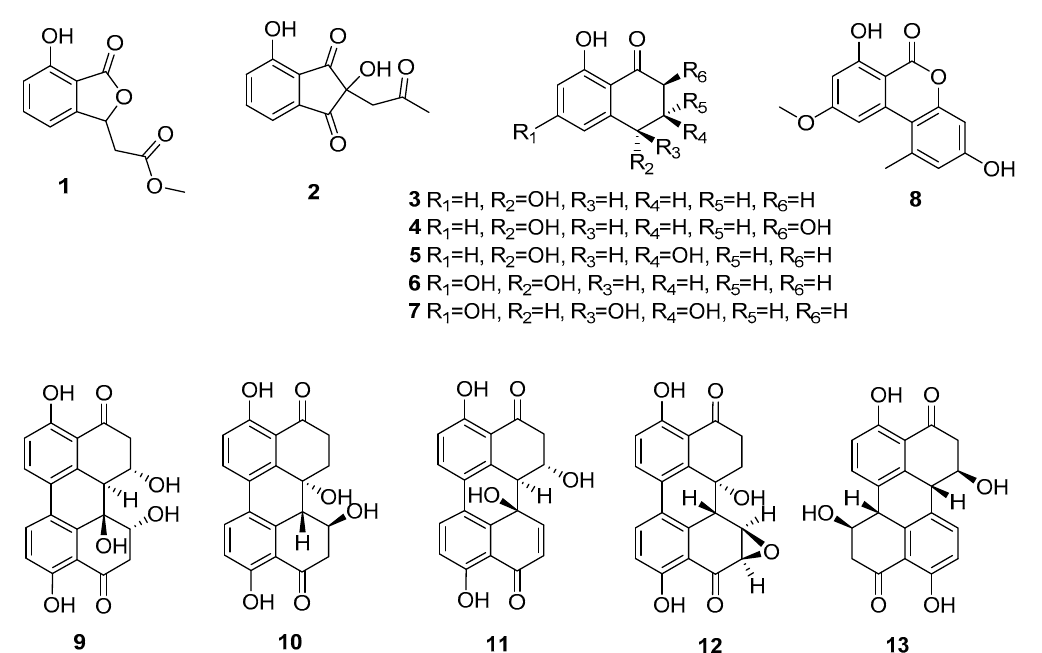
Figure 1. Structures of compounds 1 – 13 isolated from Alternaria sp. A744.